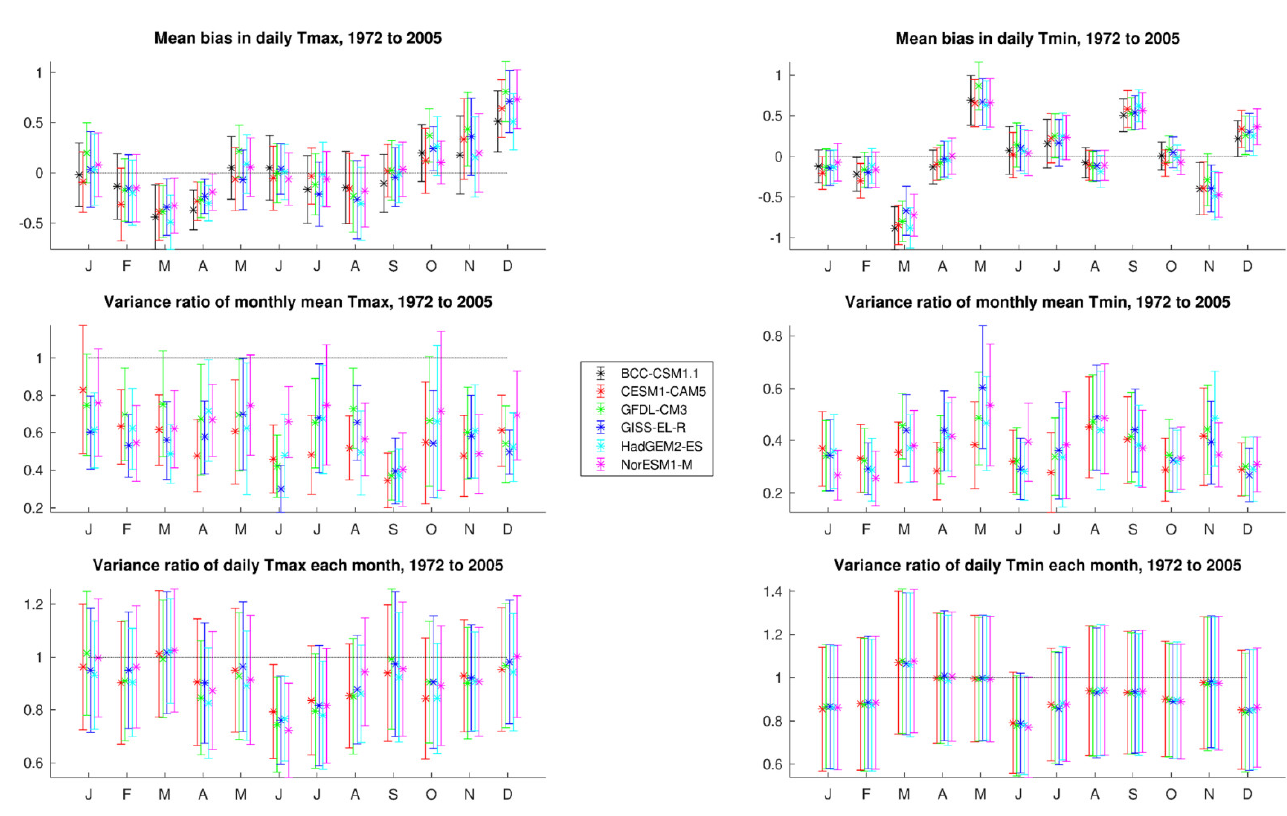
Figure A1. Mean bias and variance ratios for maximum and minimum temperatures for the Represen- tative Concentration Pathway (RCP) data series with respect to the Virtual Climate station Network (VCSN) data series, used in the correction of the RCP temperature data. Each error bar shows the mean and standard error over grid locations across New Zealand.